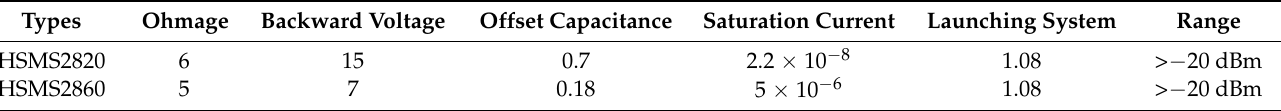
Table 1. Performance parameters of HSMS2820 and HSMS2860 Schottky